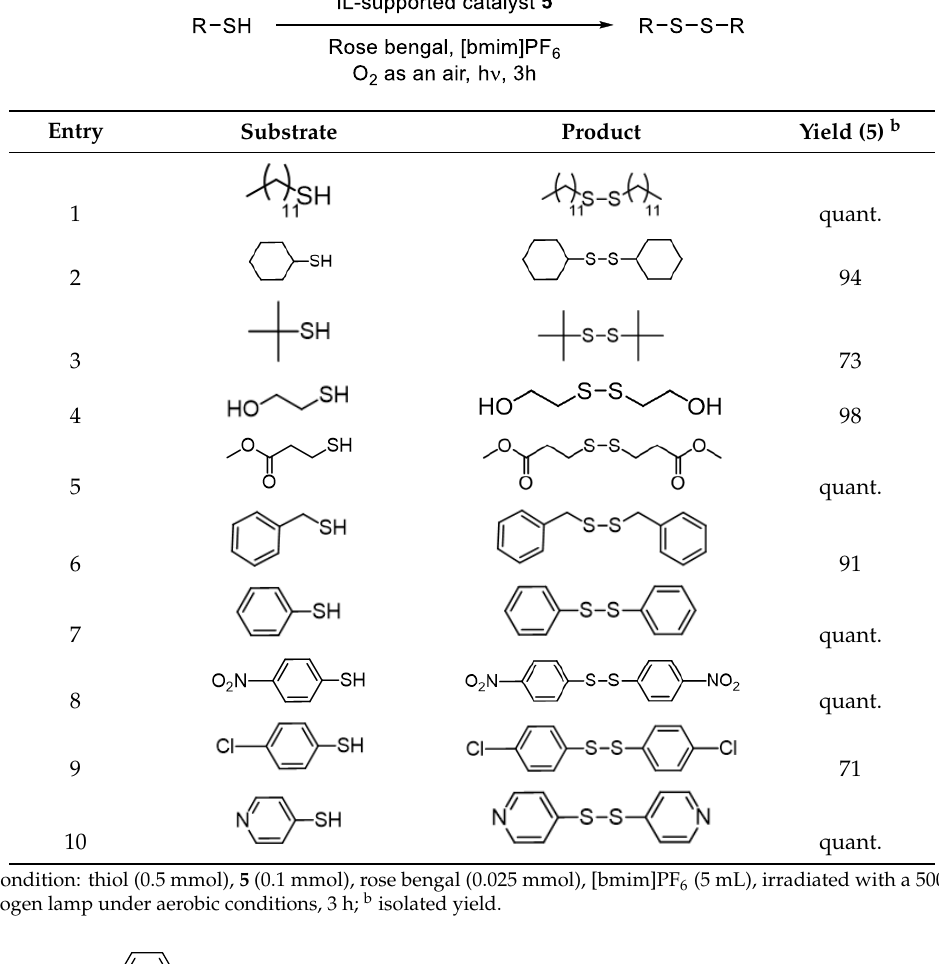
Table 2. Catalytic oxidation of various thiols using IL-supported diphenyl telluride 5 a .